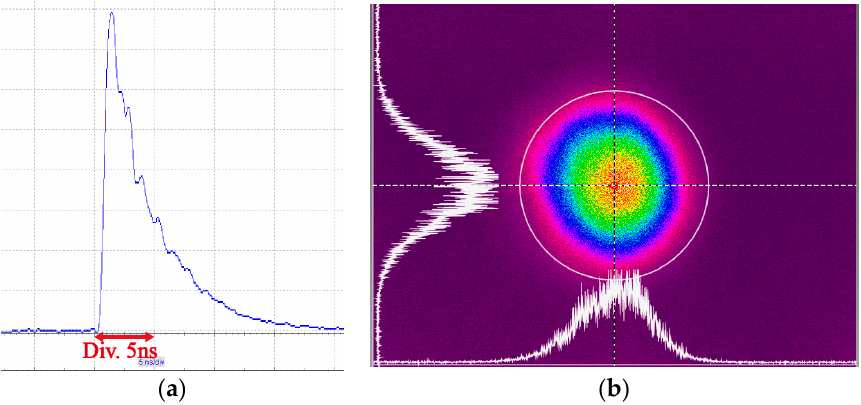
Figure 7. ( a ) Pulse duration of ~5 ns (5% OC); ( b ) Beam profile of the 1420 nm laser.